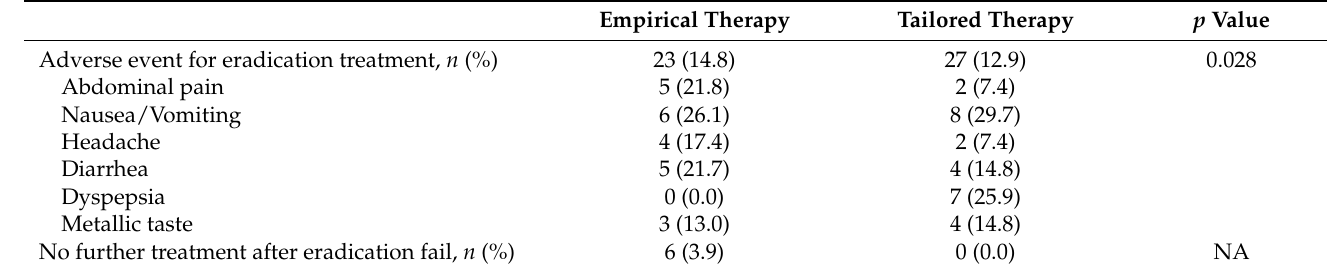
Table 3. H. pylori eradication related adverse effects of study subjects. Empirical